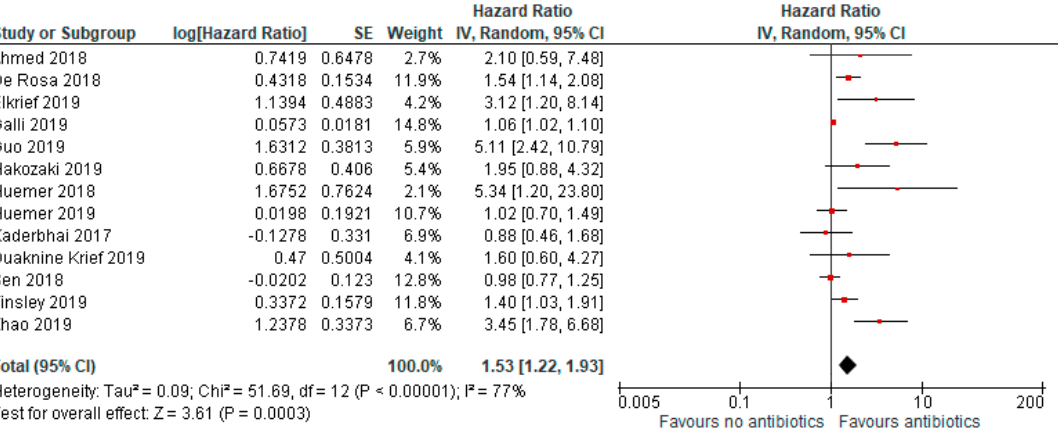
Figure 2. Forrest plot for progression-free survival in patients assuming antibiotics pre/during immunotherapy. IV, inverse variance; CI, confidence interval; SE, standard error.